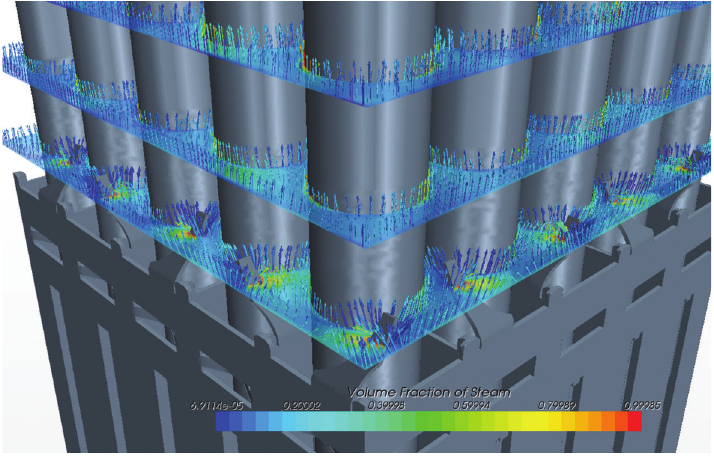
Figure 8: E ff ects of vanes on